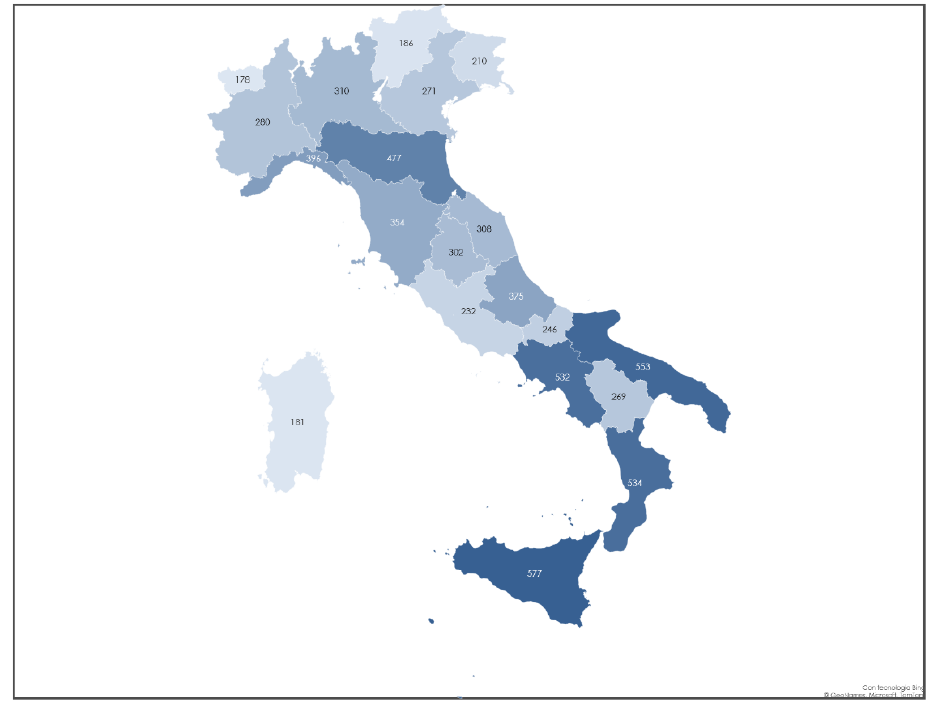
Figure 1. Distribution of number of small farms per region.